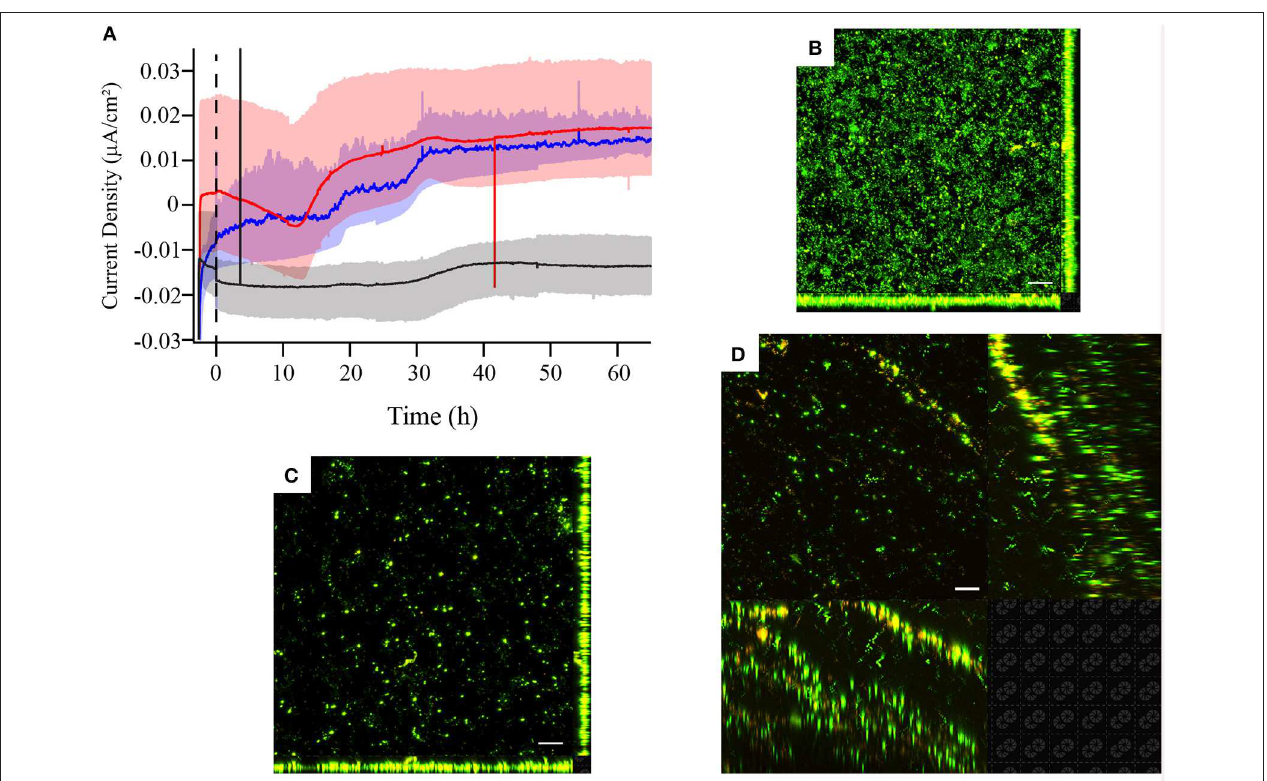
FIGURE 4 | (A) Chronoamperometry and laser scanning confocal microscopy (LSCM) of Live/Dead-stained M. atlanticus biofilms grown on (B) graphite, (C) ITO, or (D) carbon cloth working electrodes poised at 310mV vs. SHE. Microscopy was performed ca. 66h after inoculation. Fluorescence associated with SYTO9 is shown in green (live) and fluorescence associated with propidium iodide is shown in red (dead). Representative images are shown from triplicate reactors. The white scale bar represents 20 µ